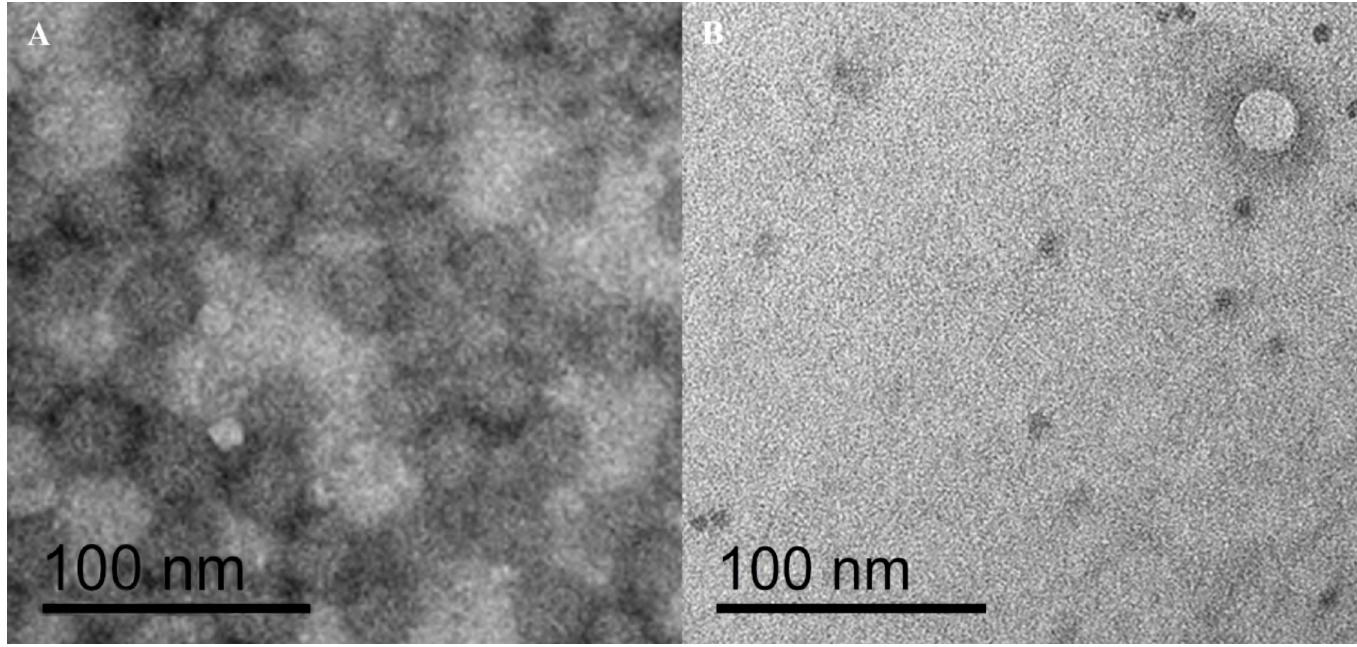
Fig 2. Electron microscopy of selected samples. A. Negative stain electron micrograph of a ground stool pool homogenate from a Myotis myotis colony. B. Negative stain electron micrograph of a pooled liver and spleen homogenate from Pipistrellus nathusii .